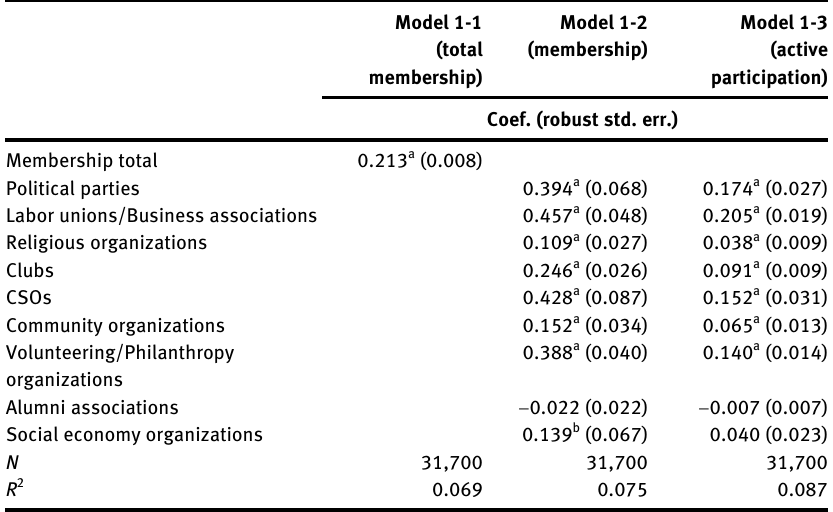
Table  : Regression analysis results: political activities and membership and participation in voluntary